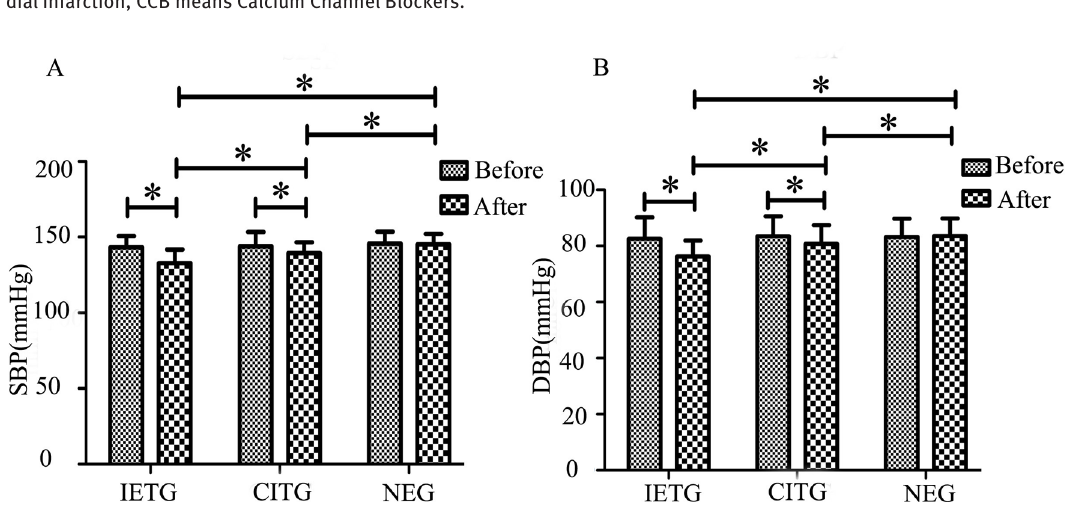
Figure 3: Comparison of BP between the three